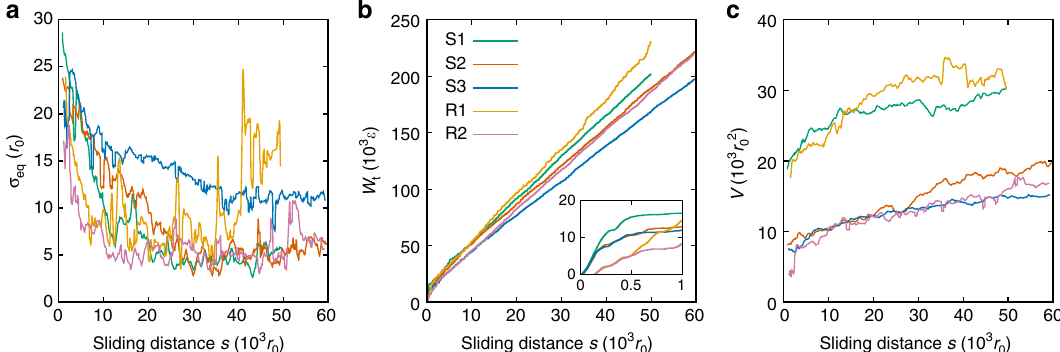
Fig. 3 Evolution of equivalent roughness σ eq , frictional work W t , and wear volume V . See Supplementary Figs. 8 and 9 for further simulations. a Evolution of σ σ eq . While for most simulations the value of eq stabilizes, cold temperatures (S3) and debris particle shape (R1) can inhibit this stabilization. b Evolution of the tangential work W t with the sliding distance. The work W t exhibits a sharp increase upon formation of the debris particle 33 (inset: W t for sliding distances up to 1000 r 0 ), after which it grows at smaller rates. c Evolution of the wear volume of the rolling debris particle, as de fi ned only after its formation. In all simulated conditions, the wear rate after the debris particle formation is small compared to the ratio of the initial particle size over the sliding distance necessary to form the particle (cf. Supplementary Fig. 6), consistent with the transition from severe to mild wear